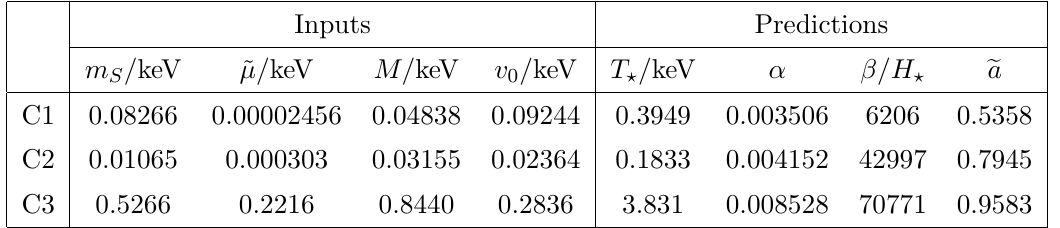
Table 3 . Values of the parameters corresponding to the three benchmark (starred) points in figure